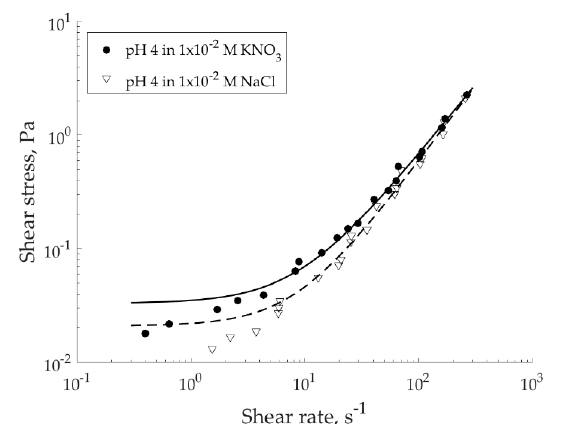
Figure 10. Local rheology computed using Equation (3), with Herschel–Bulkley fit for: pH 4 in 1 × 10 − 2 M KNO 3 (filled symbols, solid line, K = 0.0020 Pa · s, n = 1.25, τ 0 = 0.033 Pa), and pH 4 in 1 × 10 − 2 M NaCl (hollow symbols, dashed line, K = 0.0011 Pa · s, n = 1.35, τ 0 = 0.021 Pa).